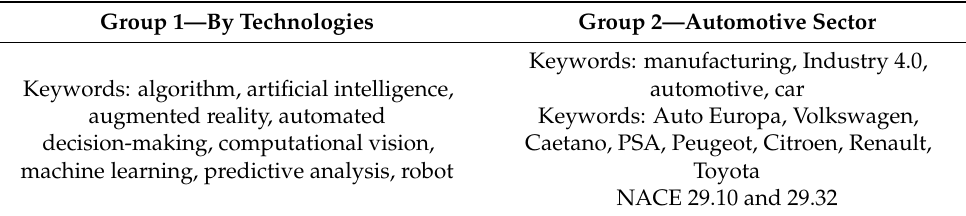
Table 1. Search strings adopted in the identification of funded AI projects in the automotive industry with an end date of